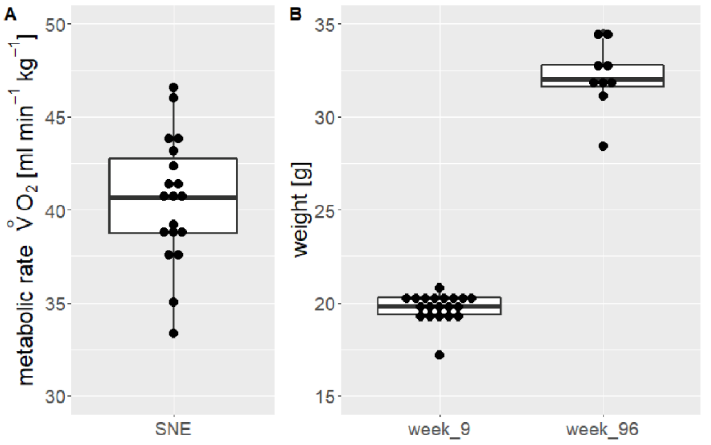
Figure 3. Summarizing boxplot of the resting metabolic rate ( A ) and the weight ( B ) of 19 female mice in the SNE. Metabolic rate was recorded at an age of 82–84 weeks. The weight is displayed at the animal age of 9 weeks and 96 weeks (start and end value).